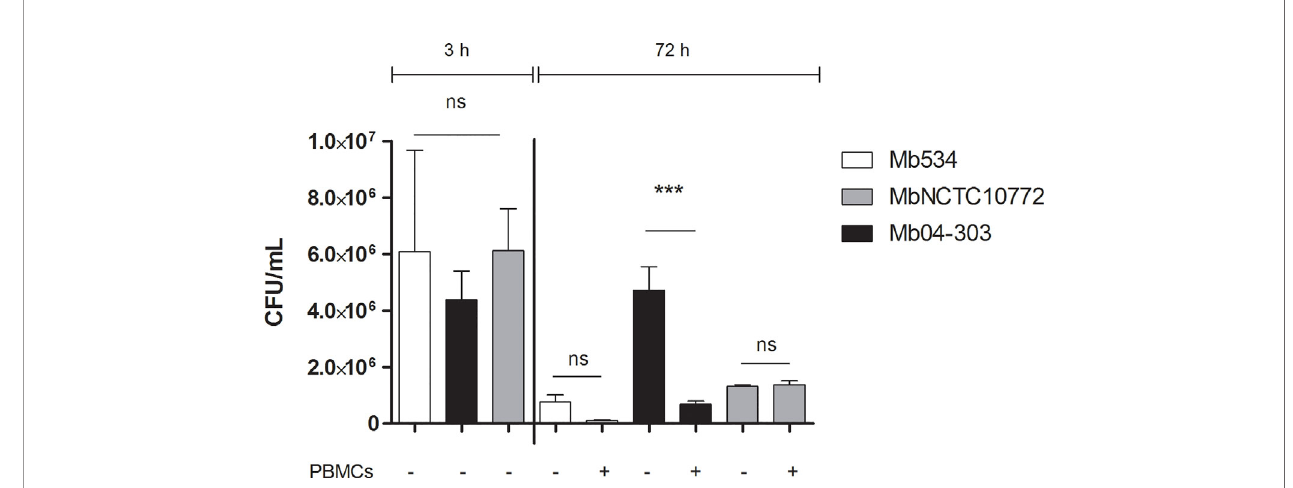
FIGURE 3 | Mycobacterial growth inhibition assay. Macrophages were infected with M. bovis strains (MOI=1) and co-cultured with autologous lymphocytes or culture media alone (control condition). Colony forming units were counted 3 h post infection (to detect any variation in inoculum between strains) and at 72 h. Cells were puri fi ed from three different calves (N=3). Macrophages and co-cultures were infected in parallel and in triplicate for each condition (technical replicates); bars represent mean values and whiskers SEM. ***p<0.001 ANOVA test with Bonferroni post-test for multiple comparisons. ns, not signi fi